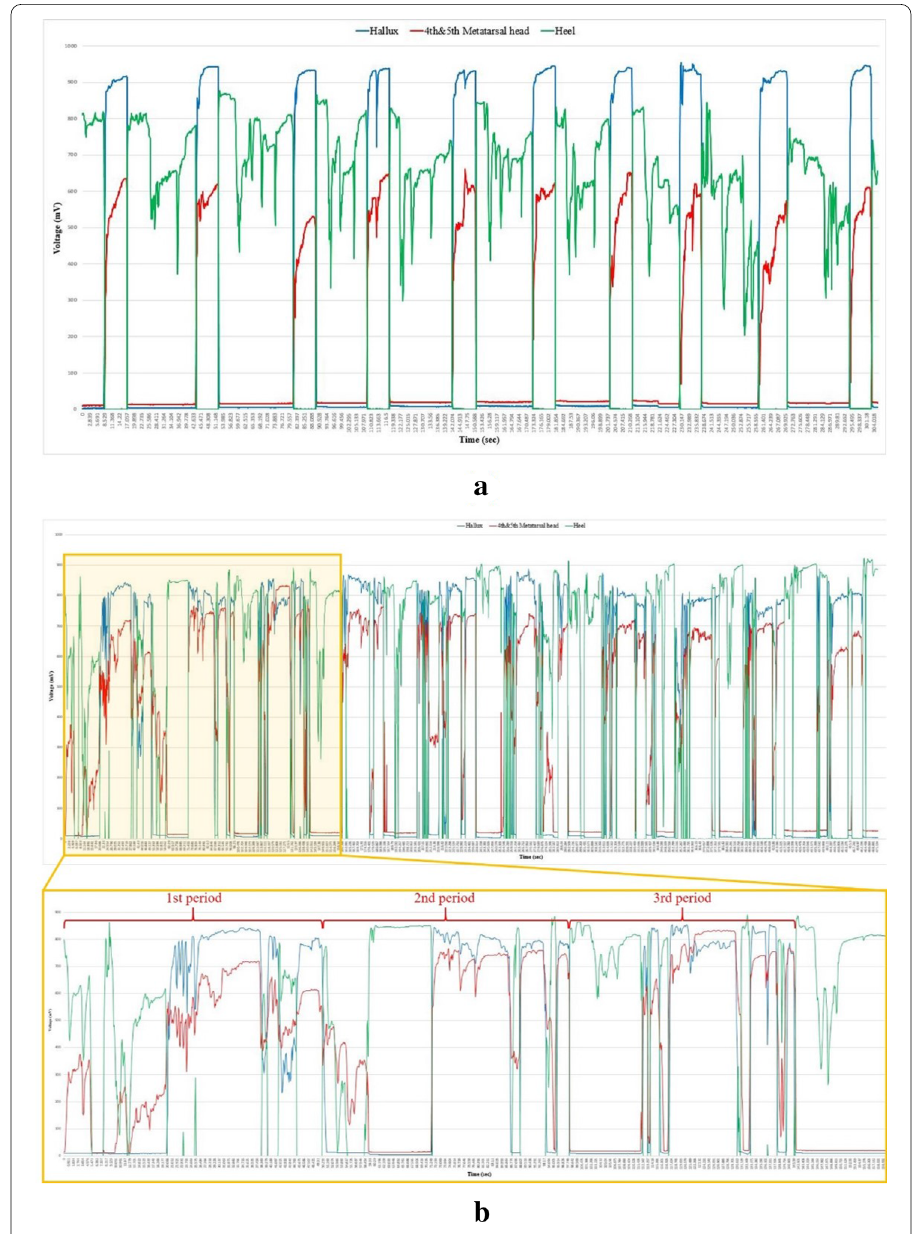
Fig. 10 Plantar pressure data of sewing operations a Operation 1 b Operation